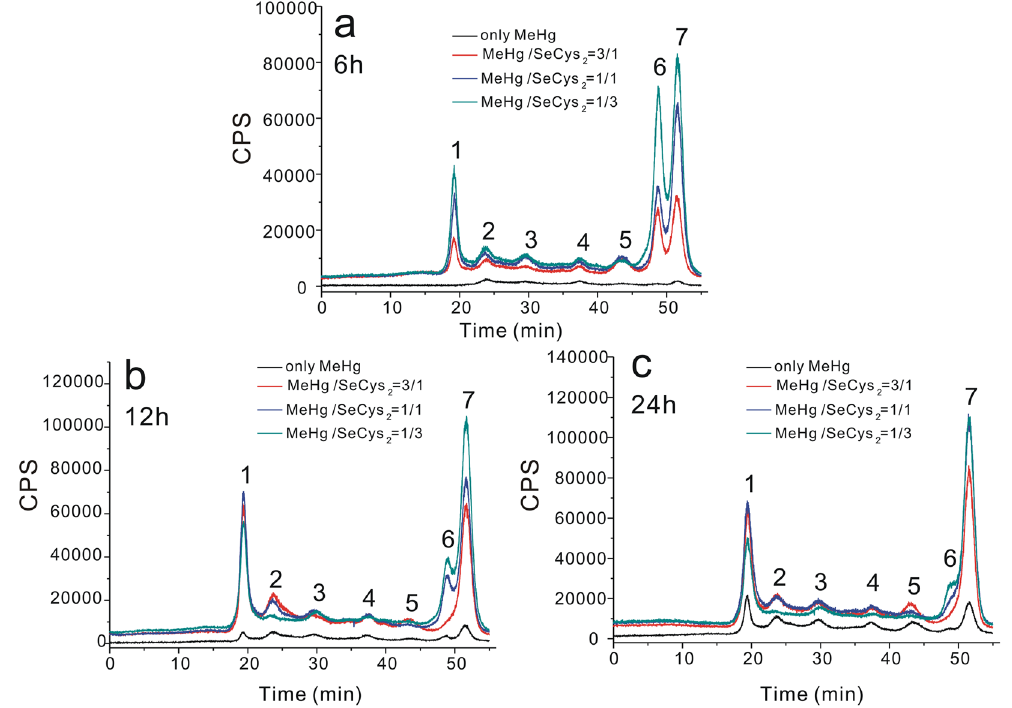
Figure 2. Chromatograms of mercury species obtained by SEC-ICP-MS for the cytosol of cells incubated with MeHg, and co-incubation with MeHg + SeCys 2 at the ratios of 3:1, 1:1, 1:3 for 6 h ( a ), 12 h ( b ) and 24 h ( c ), respectively. (Information of molecular weight: fraction 1 > 669 kDa, 669 kDa > fraction 2 > 440 kDa, 440 kDa > fraction 3 > 67 kDa, 67 kDa > fraction 4 > 35 kDa, 35 kDa > fraction 5 > 6512 Da, fraction 6 and 7 < 1355